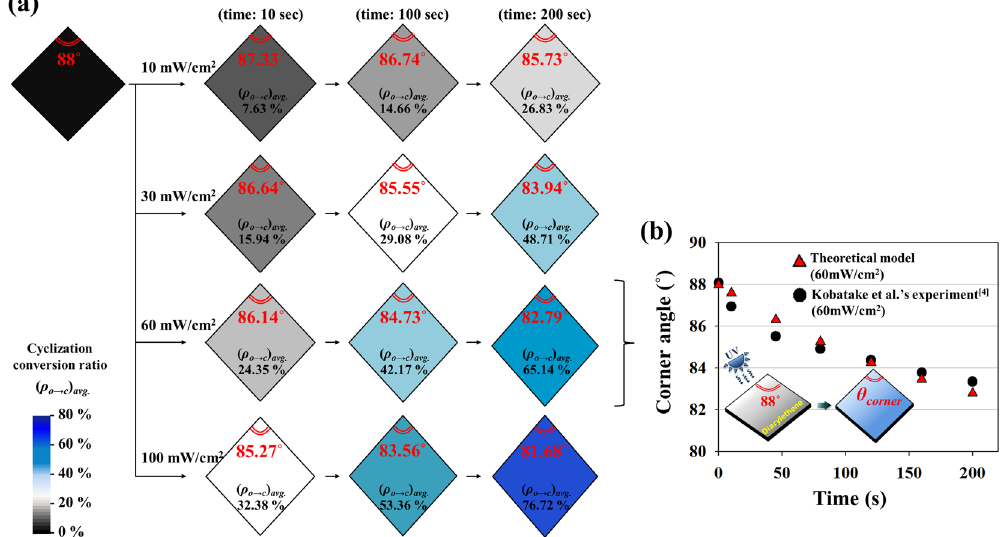
Figure 6. ( a ) Predicted in-plane shear deformation induced by UV irradiation. Corner angle and cyclization conversion ratio of lozenge-shaped single crystal are indicated in insets. (sample: 1,2-bis(2-ethyl-5-phenyl-3- thienyl)perfluorocyclopenetene single crystal, thickness: 0.57 μ m, light wavelength: 350.58 nm, light intensity: 10–100 mW/cm 2 ) ( b ) Experimental comparison (red triangular point: Kobatake et al .’s report 4 ) with our model at 60 mW/cm 2 of UV